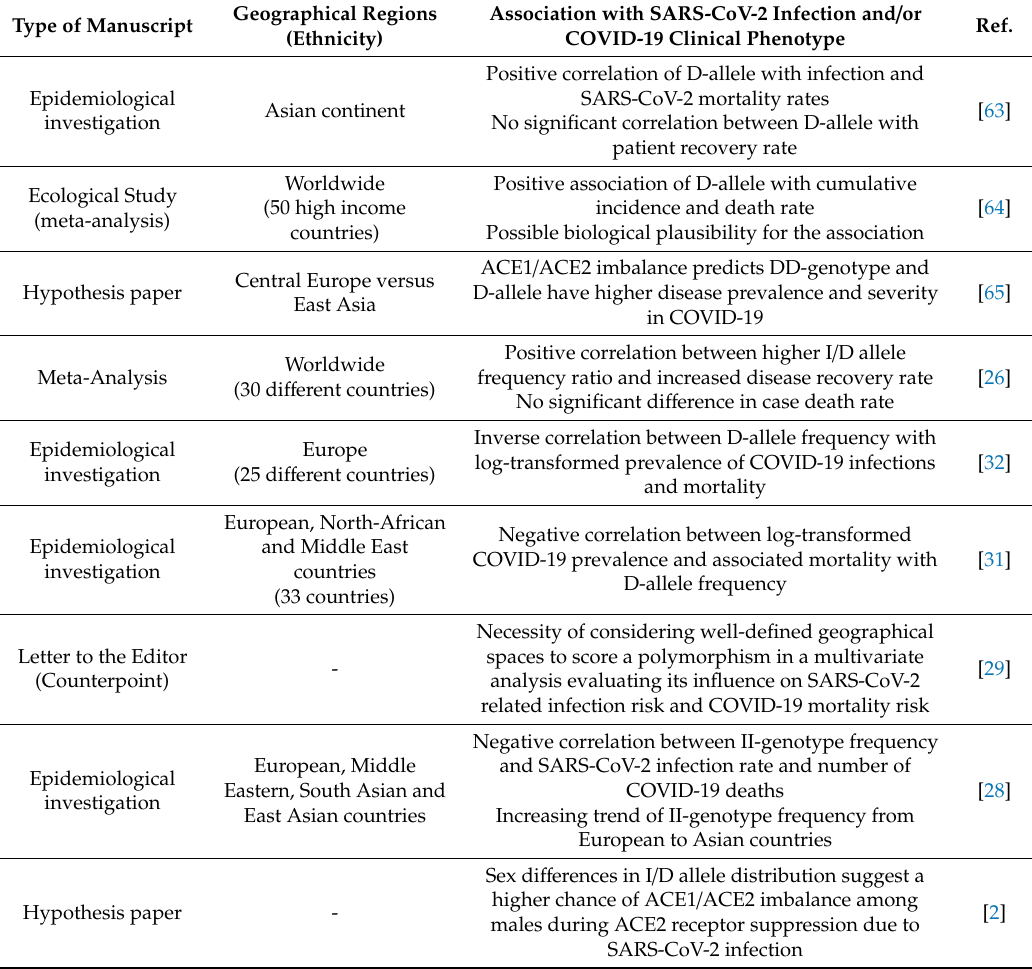
Table 1. Relevant publications dealing with ACE1 I / D polymorphism in